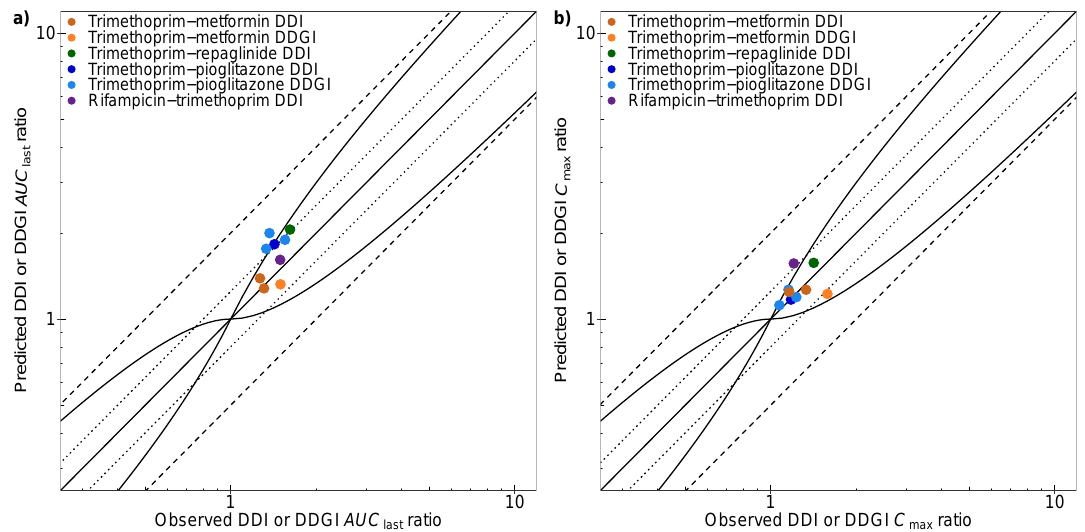
Figure 7. Trimethoprim DDI model performance. Predicted compared to observed DDI and DDGI ( a ) AUC last ratios and ( b ) C max ratios of all clinical studies used to evaluate the DDI performance of the trimethoprim model. The straight solid line marks the line of identity and the curved solid lines show the DDI prediction acceptance limits proposed by Guest et al. [74]. Dotted lines indicate 1.25-fold and dashed lines indicate 2-fold deviation. Data are shown as dots [4–7,16]. Details on the predicted clinical studies and the individual DDI and DDGI AUC last and C max ratios are provided in the Supplementary